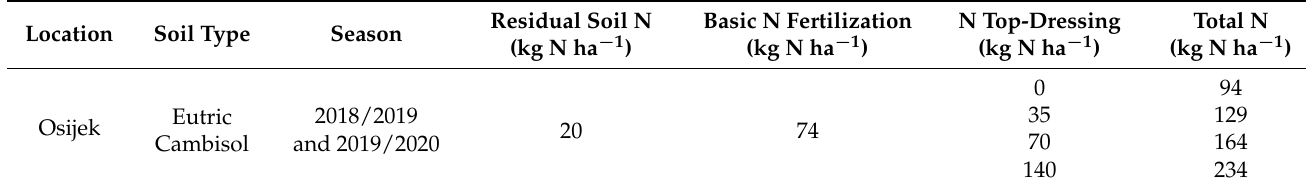
Table 1. Soil nitrogen (N) content (kg ha − 1 ) in Osijek in 2018/2019 and 2019/2020 year. Location Soil Type